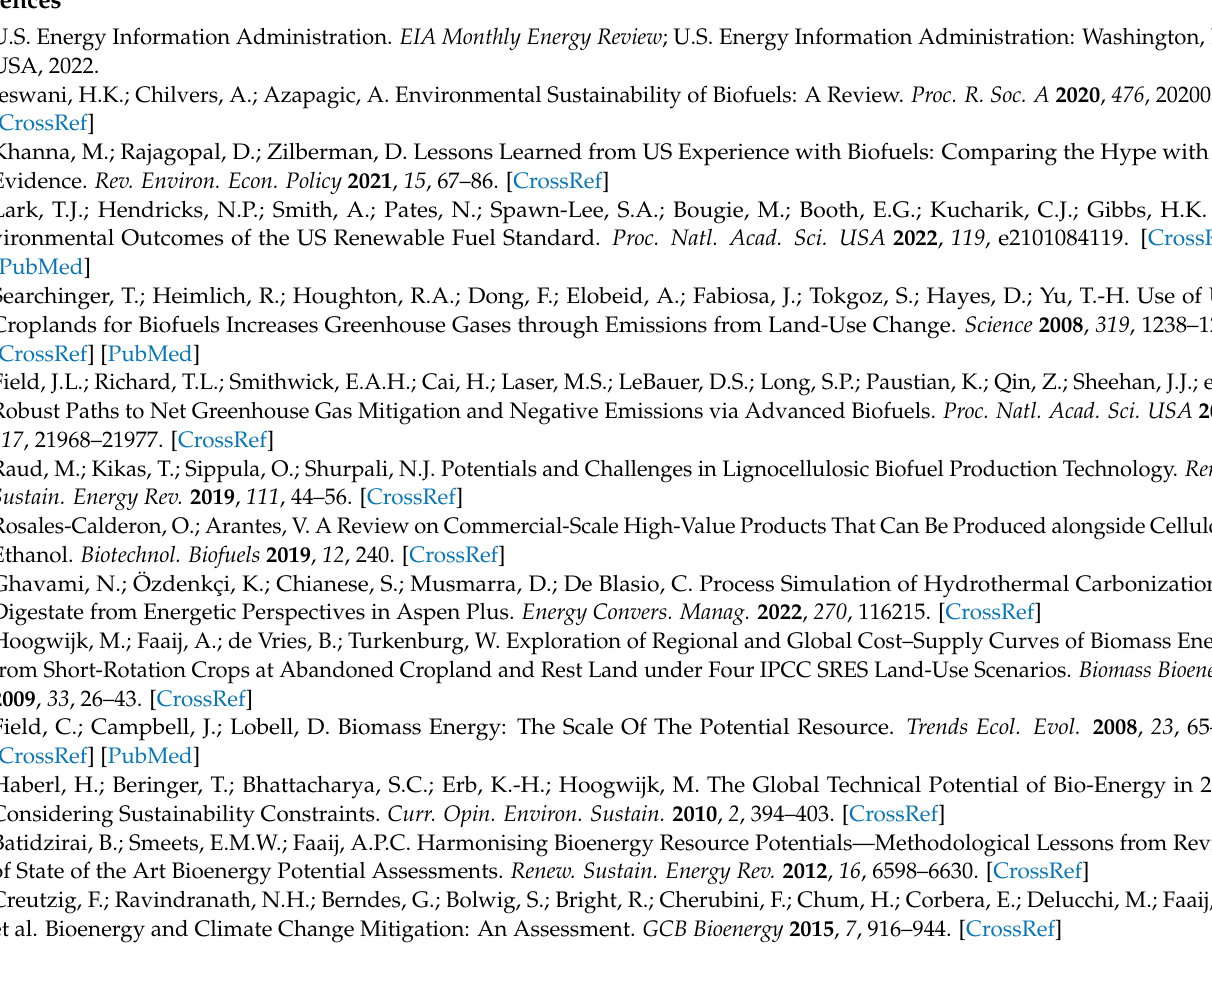
States; Table S2. Forestland inventory in the US in 2010; Table S3. Costs of production for biofuel feedstocks in 2010; Table S4. Parameters for calibrating learning-by-doing curves of biofuel processing costs; Table S5. Stand establishment costs for different stands; Table S6. Cost of harvesting 30-year- old trees; Table S7. Life-cycle GHG emission factors associated with different inputs and processes; Table S8. Energy embodied in ethanol production from different lignocellulosic biomass; Table S9. Annual yield and soil carbon sequestration by feedstock; Table S10. Model validation for 2010 and 2015 (model output); Table S11. Cumulative land use change under alternative scenarios by region relative to the No-cell case, 2015-2035 (M ha) (model output). Sourece: Refs. [64–69]. Institutional Review Board Statement: Not